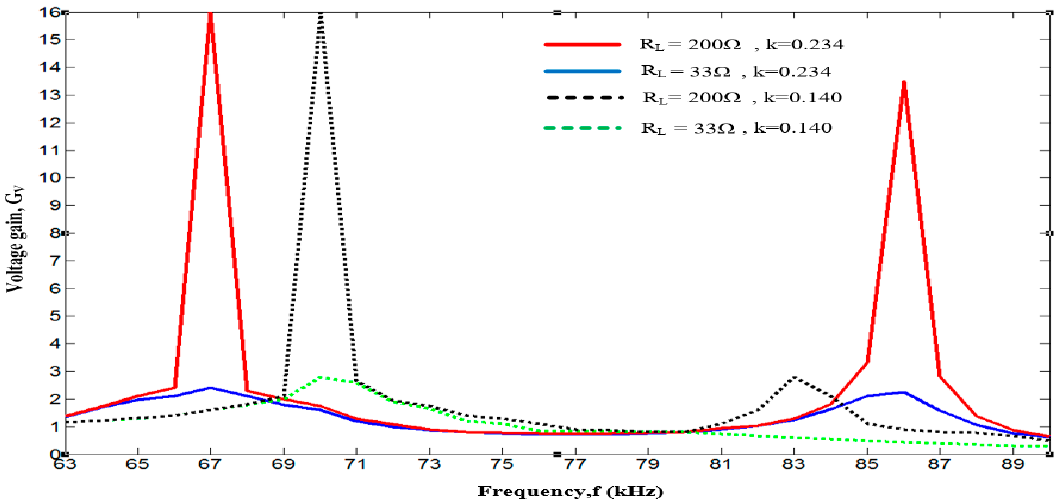
Figure 6. Measured voltage gain of the 500 W LC-LC2 compensated resonant converter.